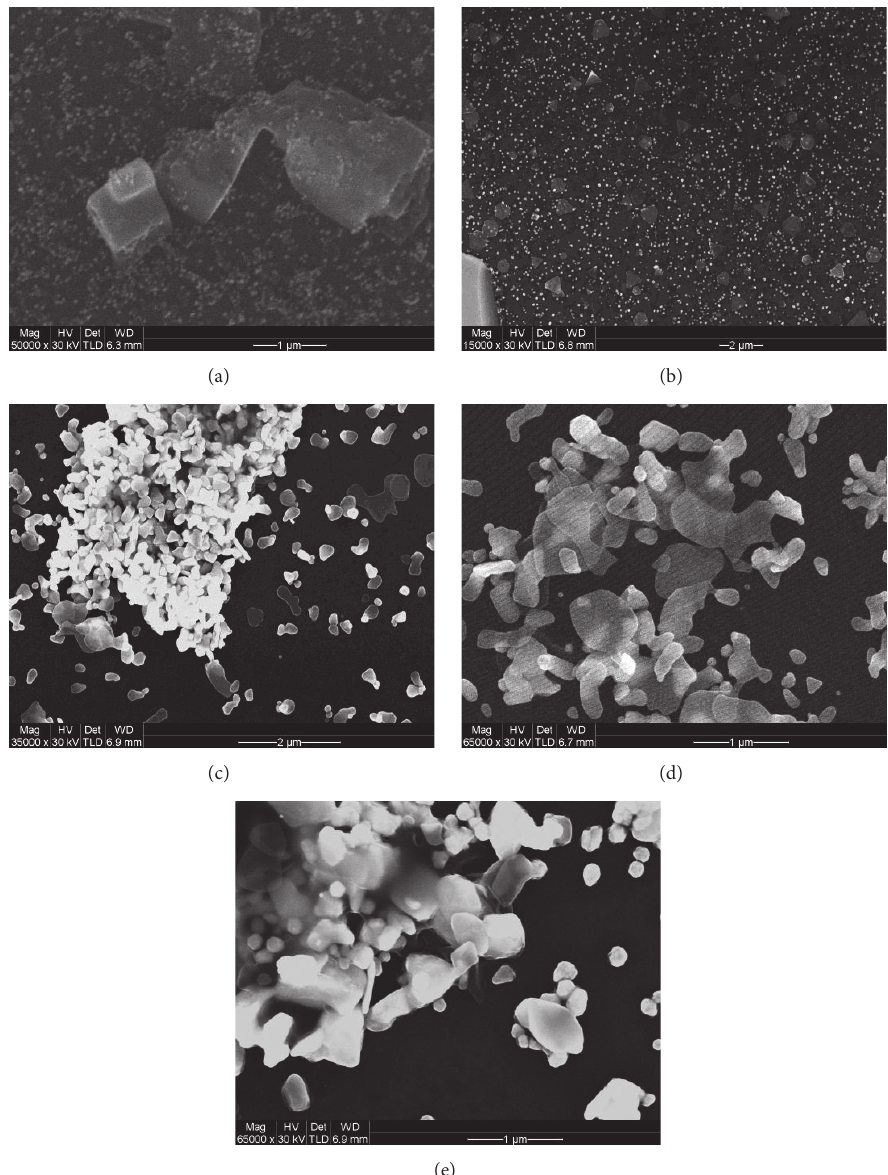
Figure 4: SEM images showing results from gold nanoparticle synthesis with variances in concentration of 5-HIAA. (a) 0.150 mM, (b) 0.075 mM, (c) 0.038 mM, (d) 0.025 mM, and (e) 0.019